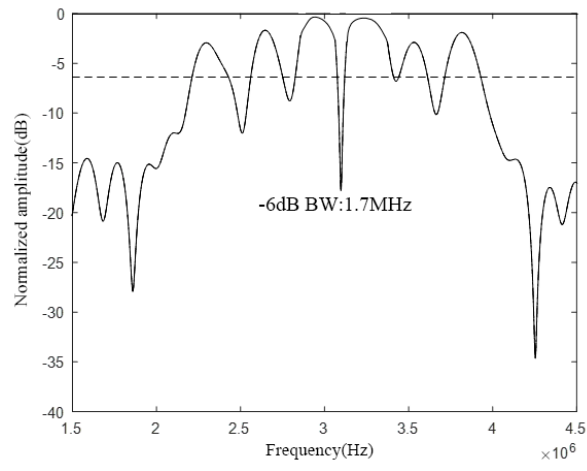
Figure 15. CMUT bandwidth ( w = 20%).